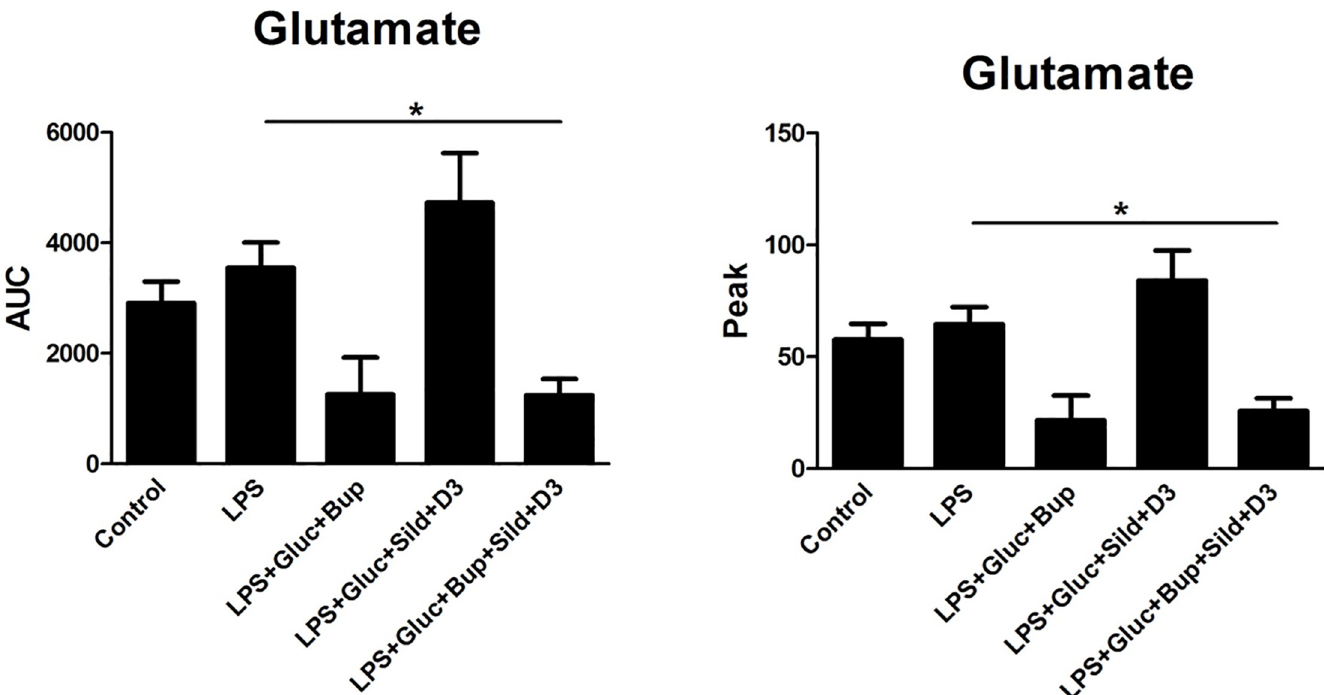
Fig 2. Astrocytes were incubated with the Ca 2+ -sensitive probe FLIPR Calcium 6. Glutamate (10 − 3 M) was used as a stimulator to detect changes in intracellular Ca 2+ release. The cells were cultivated in 5.5 mM glucose for the entire cultivation period. Ca 2+ responses were measured after the cells were stimulated with glutamate (control), incubated with LPS (10 ng/ml) for 24 h, or incubated with LPS for 24 h followed by LPS, 25 mM glucose + bupivacaine (Bup) (10 − 12 M), 25 mM glucose + sildenafil (Sild) (1 μ M) + vitamin D3 (D3) (100 nM), or a combination of all substances for an additional 24 h. The area under the curve (AUC) of the Ca 2+ peak was calculated for each Ca 2+ transient, and the amplitude (peak) was expressed as the maximum increase. The cells were obtained from 4 experiments with quadruple wells in each. The level of significance was calculated against LPS and was analyzed using a one-way ANOVA followed by Dunnett’s multiple comparisons test. � P < 0.05.